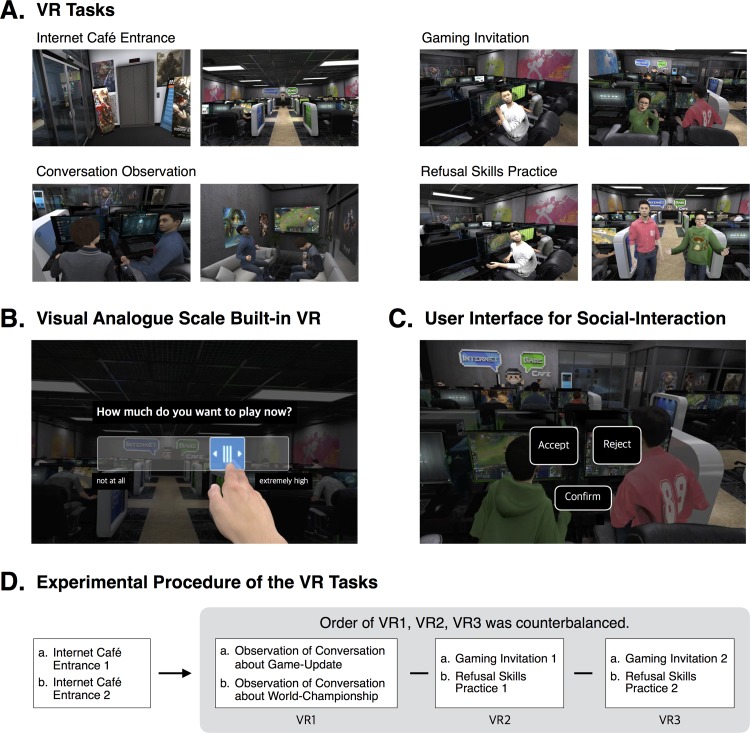
Screenshots of virtual environment and experimental procedure of virtual reality tasks.